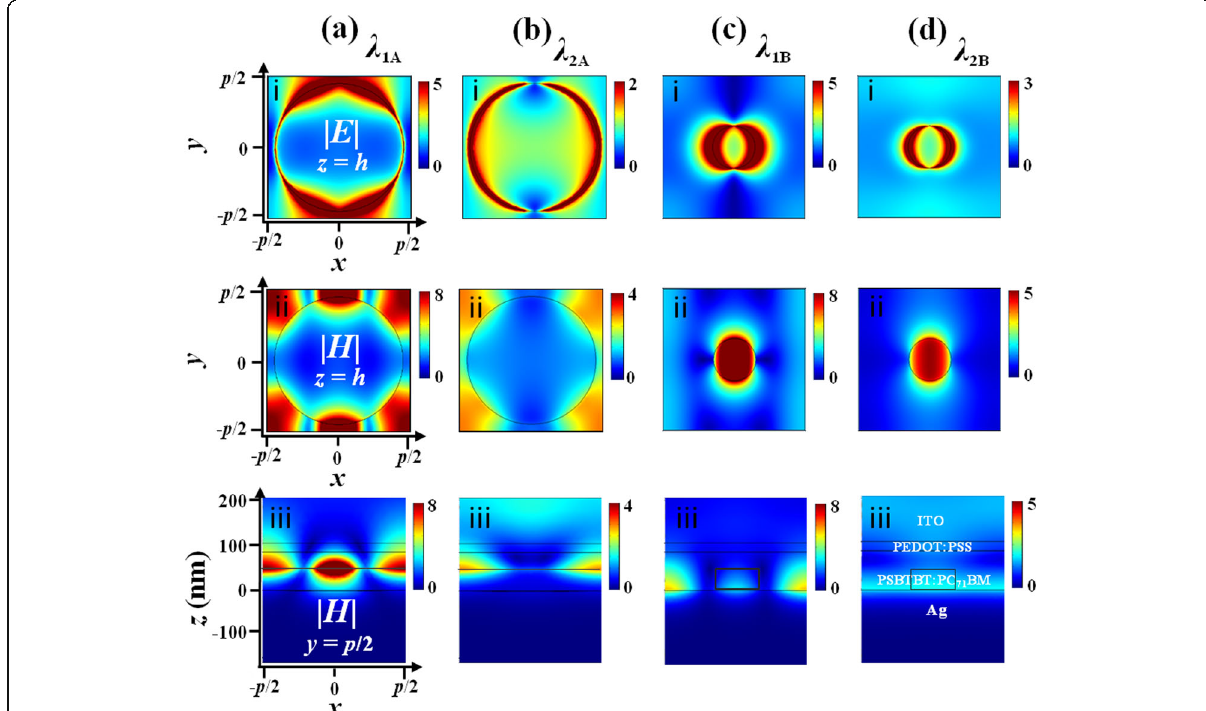
Fig. 4 Field maps under TM polarization at different cross sections at the peaks of λ 1A ( a ), λ 2A ( b ), λ 1B ( c ), and λ 2B ( d ). First row | E | at z = h A or h B , middle row | H | at z = h A or h B , and bottom row | H | at y = p A /2 or p B /2. The peaks are as labeled in Fig.